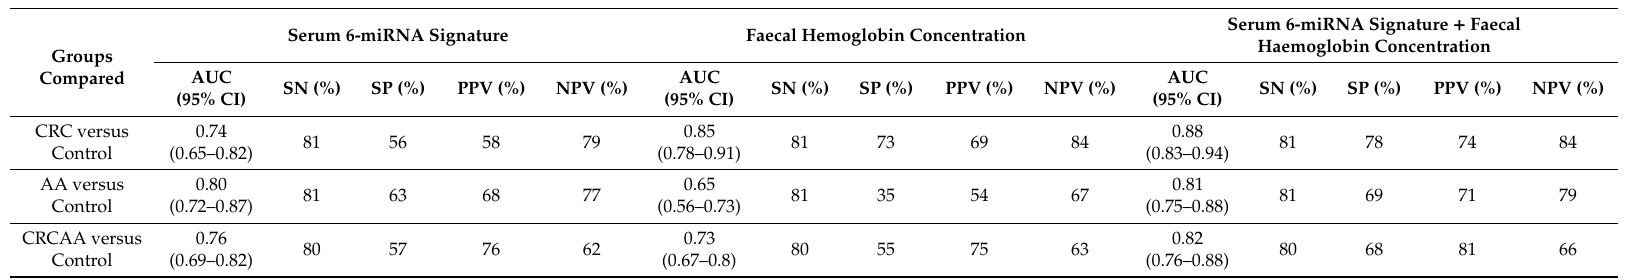
Table 2. Summary data of the discriminative capacity of the serum 6-miRNA signature or faecal haemoglin concentration from ROC curve analysis, and values from combination of both. AUC: area under the curve; CI: confidence interval; SN: sensitivity; SP: specificity; PPV: positive predictive value; NPV: negative predictive value. AA: Advanced adenomas; CRC: Colorectal cancer; CRCAA: advanced colorectal